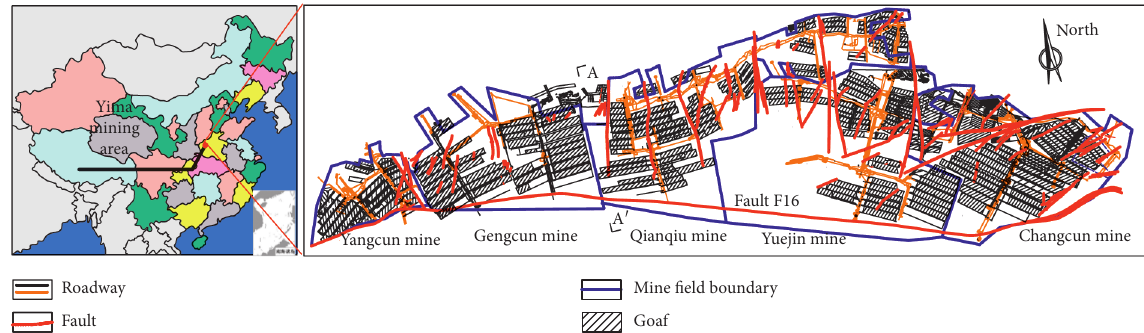
Figure 1: The geographical location, current state of mining, and tectonic distribution of the Yima mining area.